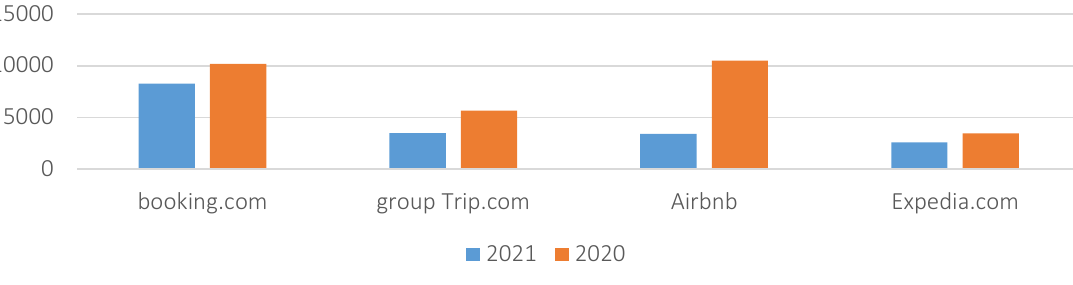
Figure 3. Number of ATMs and terminals in Ukraine in 2015–2020